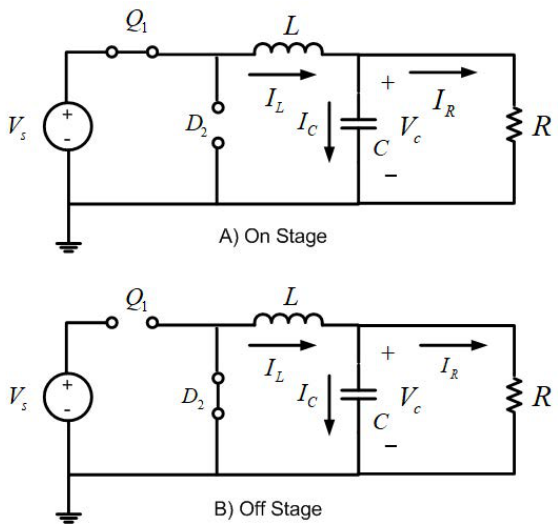
Figure 2. Functioning stages of DC-DC Buck power converter. ( a ) The switching element is on; ( b ) the switching element is